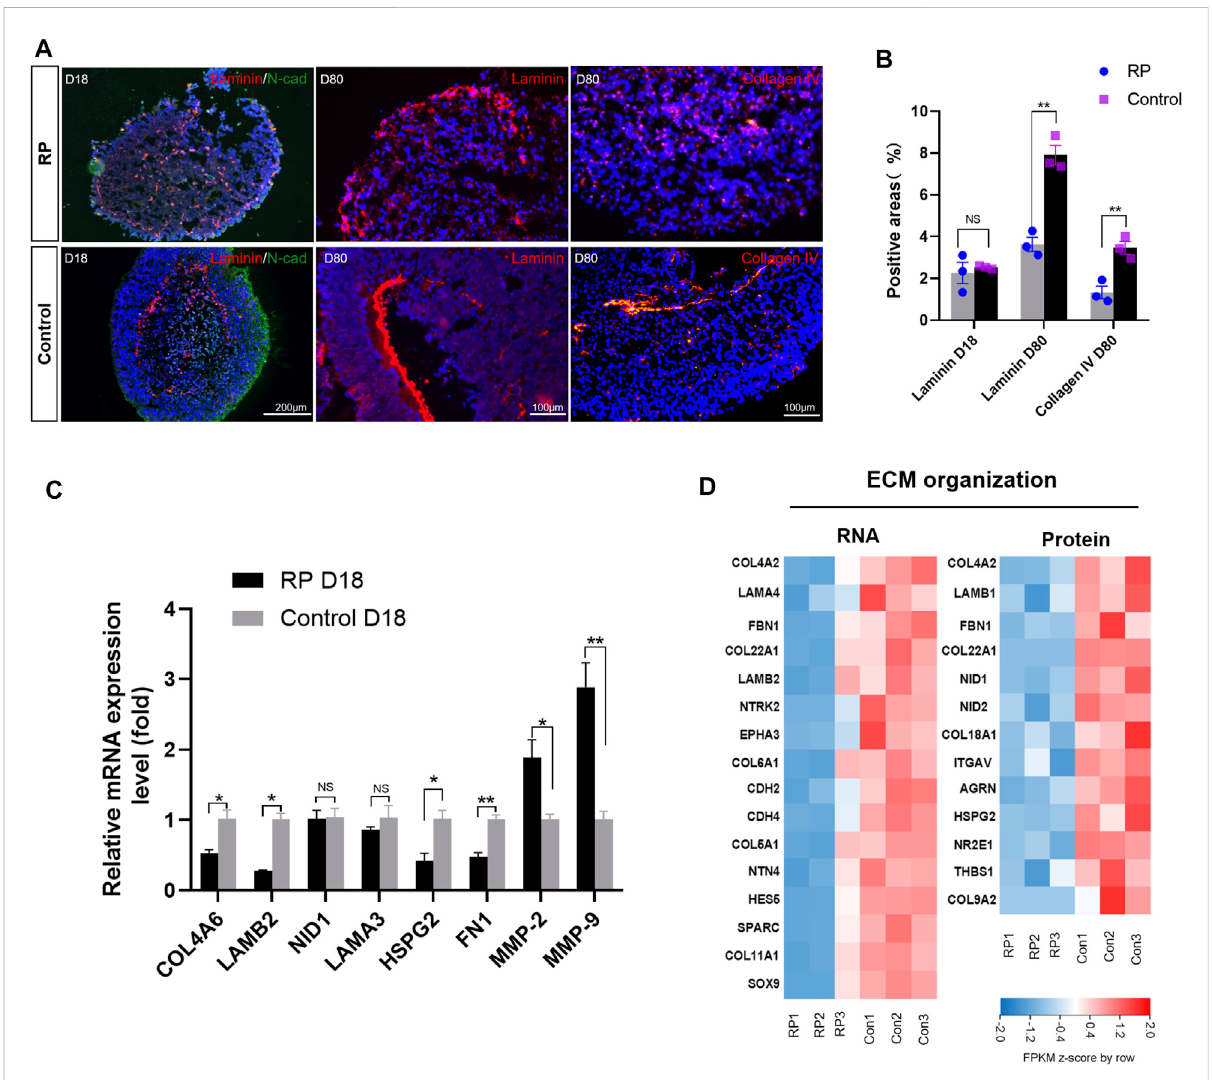
FIGURE 5 RPiPSCs derived ROs showing abnormal ECM organization functions. (A) Immunostaining of laminin (red) and collagen IV (red) of ROs in both groups. (B) Quanti fi cation of positive areas with laminin and collagen IV. (C) RT-qPCR results showing the expression of ECM-related molecules. Data are shown as mean ± SD. * p < 0.05, ** p < 0.01, *** p < 0.001, ns: no signi fi cance ( n = 3). (D) Heatmap of gene and protein expression changes related to ECM organization of ROs at D18. Upregulated and downregulation expression are in red or blue respectively. Bar is representing Z-score. Con: